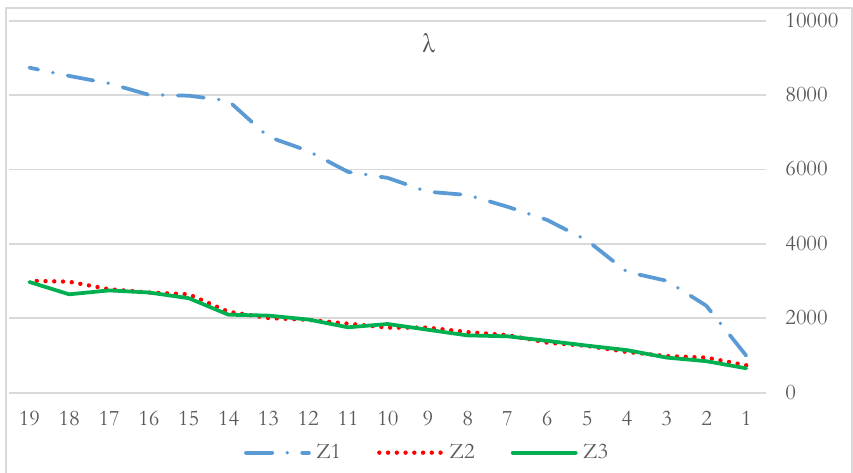
Fig. 4. Changes in the objective function by changes in λ